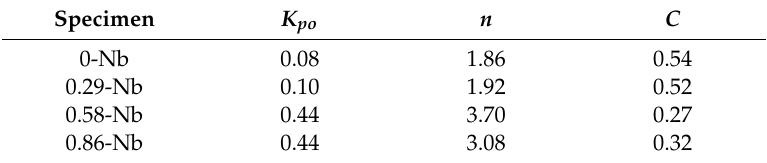
Table 3. Fitting parameters of thermal gravimetric analysis (TGA) data using the power law.